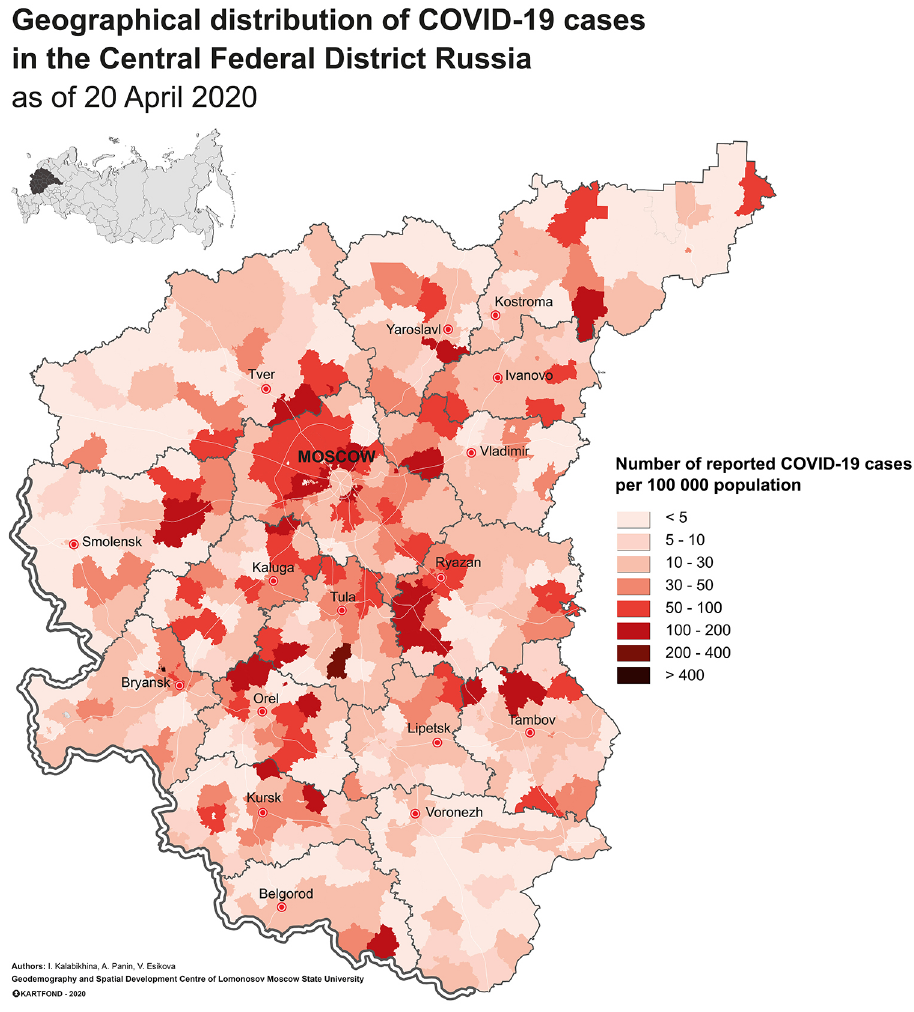
Figure 14. Geographical distribution of COVID­19 cases in the municipalities of the Central Federal District of Russia, number of reported COVID­19 cases per 100 thousand population, 20.04.2020, ac­ cording to Rospotrebnadzor (2020). Source: Compiled by the researchers of the Geodemography and Spatial Development Centre of the Population Department of the Economics Faculty of Lomonosov Moscow State University together with the “Kartfond” research